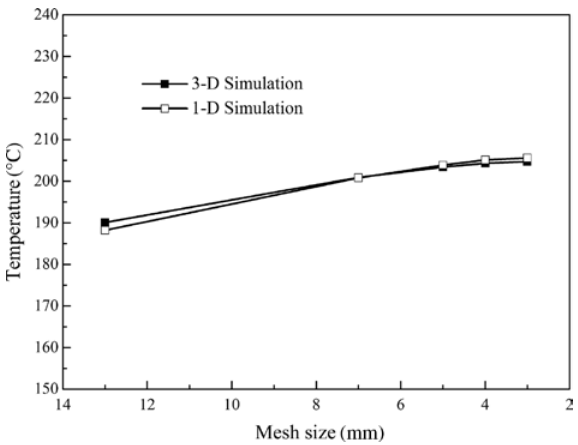
Figure 1: Mesh convergence test.